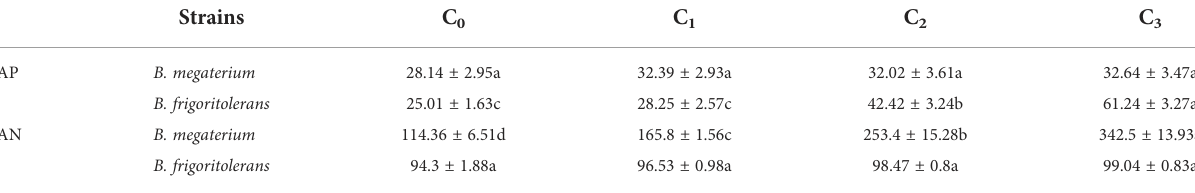
TABLE 1 Effect of Bacillus on soil available nutrients after being treated with root exudates of F. bidentis . Strains